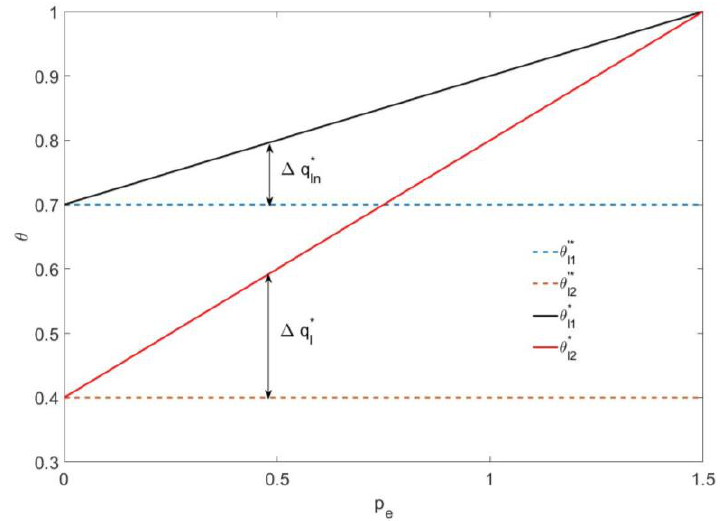
Figure 3. The effect of e p on the utility type of consumers under a leasing strategy.